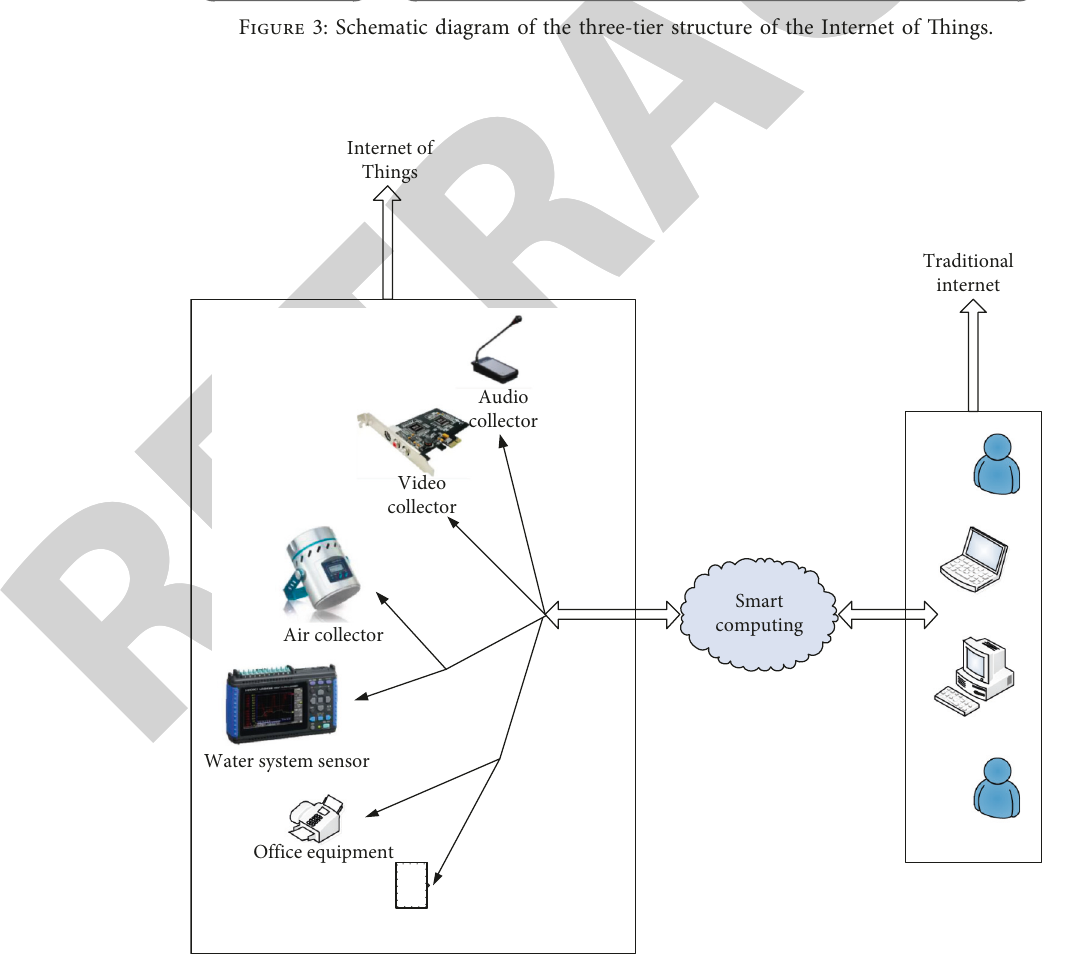
Figure 3: Schematic diagram of the three-tier structure of the Internet of Things.